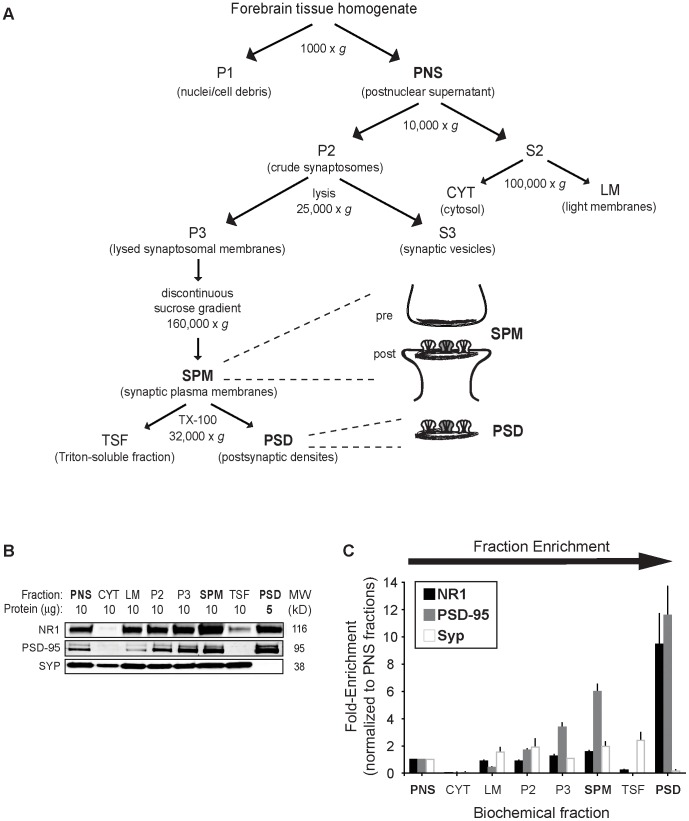
Subcellular fractionation of presynaptic and postsynaptic proteins in forebrain neurons.(A) Schematic illustration of the enrichment process, highlighting the key fractions examined in this study (see Methods for details). The PNS fraction obtained from the homogenate is subjected to a series of centrifugation steps to isolate pre- and postsynaptic plasma membranes (SPM), including layering on a sucrose gradient, and finally extracting with detergent to obtain the postsynaptic densities (PSD). (B) Representative immunoblots show NR1, PSD-95, and synaptophysin (Syp) expression in fractions from P16 mouse forebrain, with 5 or 10 µg total protein loaded in each lane as indicated. (C) Quantification of fraction fold-enrichment made with sample values normalized to PNS fractions. Error bars represent SEM. PNS, postnuclear supernatant; CYT, cytosol; LM, light membranes; P2, crude synaptosomes; P3, lysed synaptic membranes; SPM, purified synaptic plasma membranes; TSF, Triton-soluble fraction; PSD, postsynaptic densities.